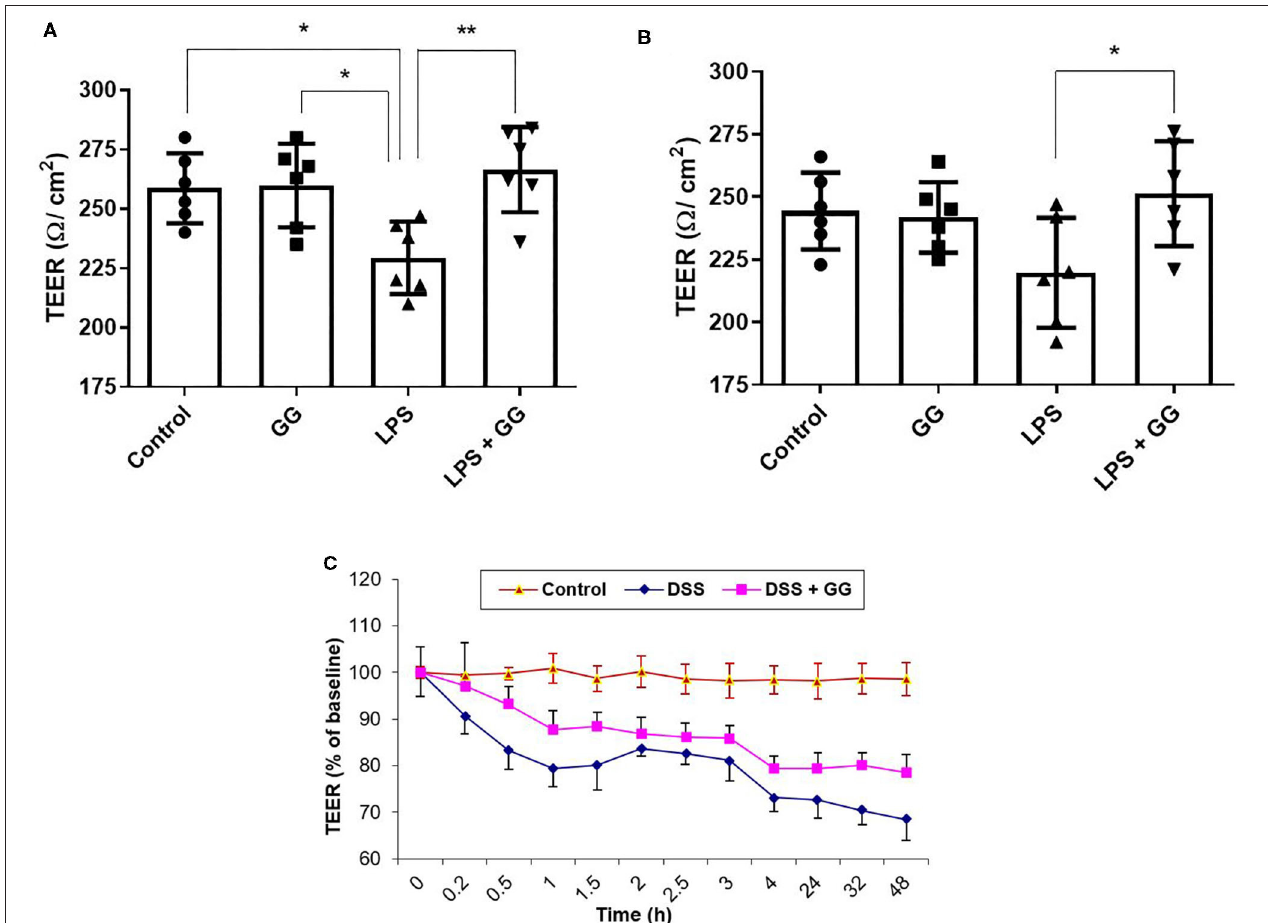
FIGURE 2 | Ganglioside mitigates the reduction in TEER induced by pro-inflammatory stimuli. TEER was measured at (A) 8h and (B) 24h, and in a (C) 48h timecourse after exposure to pro-inflammatory stimuli ( N = 6 biological replicates in cell culture wells per group; N = 3 technical instrument reader replicates). For (C) , TEER measurement was 237 ± 5 (cid:127) /cm 2 at time = 0h. Values illustrated the mean ± SD. Asterisks denotes statistical significance at * p < 0.05, ** p < 0.01. In panel (C) , “DSS” significantly differs ( p < 0.05) from “DSS + GG” at all-time points after 0h. GG, ganglioside.